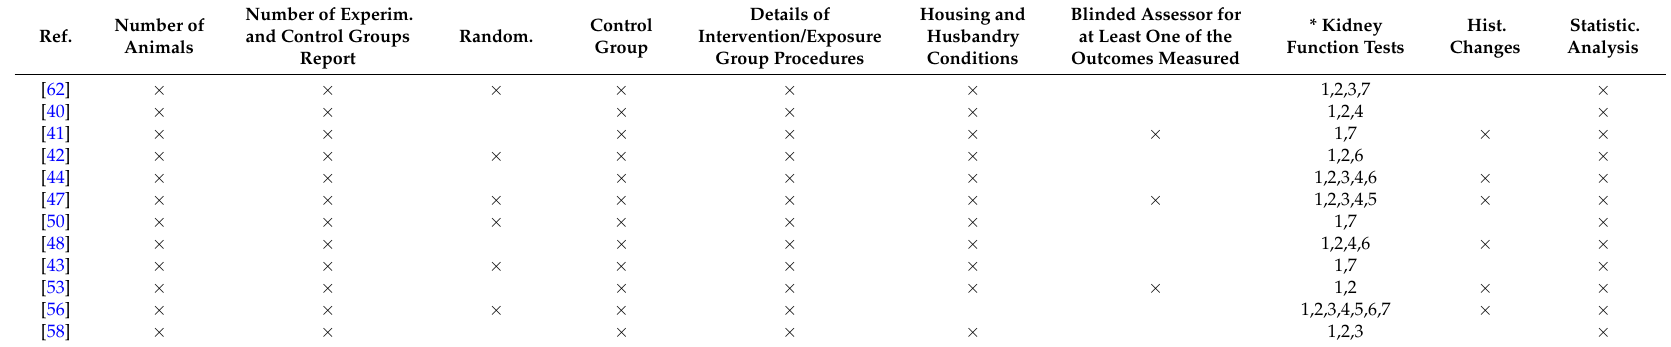
Table note: × = The criterion is satisfied; * Kidney function tests: 1 = serum urea and creatinine, or/and albumin, protein; 2 = Oxidative stress indices (e.g., nitric oxide and lipid peroxidation); 3 = Antioxidants (Superoxide dismutase activity, catalase); 4 = Sulphur compounds (Gamma glutamyltransferase); 5 = Assessment of renal inflammation (tumor necrosis factor-a; IL-6); 6 = Tissue supernatants; 7 = Urine analysis (albumin or glucose or